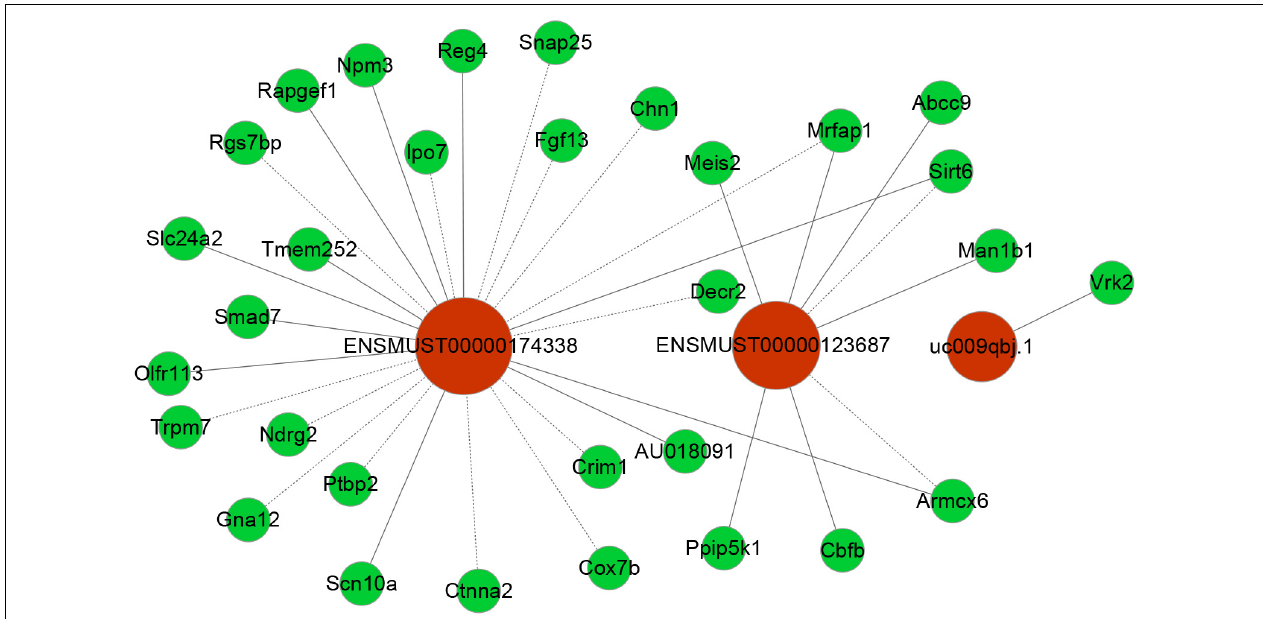
FIGURE 6 | Co-expression networks of third lncRNAs with associated mRNAs. Co-expressed lncRNA-mRNA pairs were identified through strict screening criteria (correlation coefficients > 0.95 or < –0.95, P < 0.01). The differentially expressed lncRNAs were predicted to function by regulating the closely related mRNA. Red circles represent lncRNAs, and green circles denote mRNAs. Solid and dotted lines represent positive correlation and negative correlation,